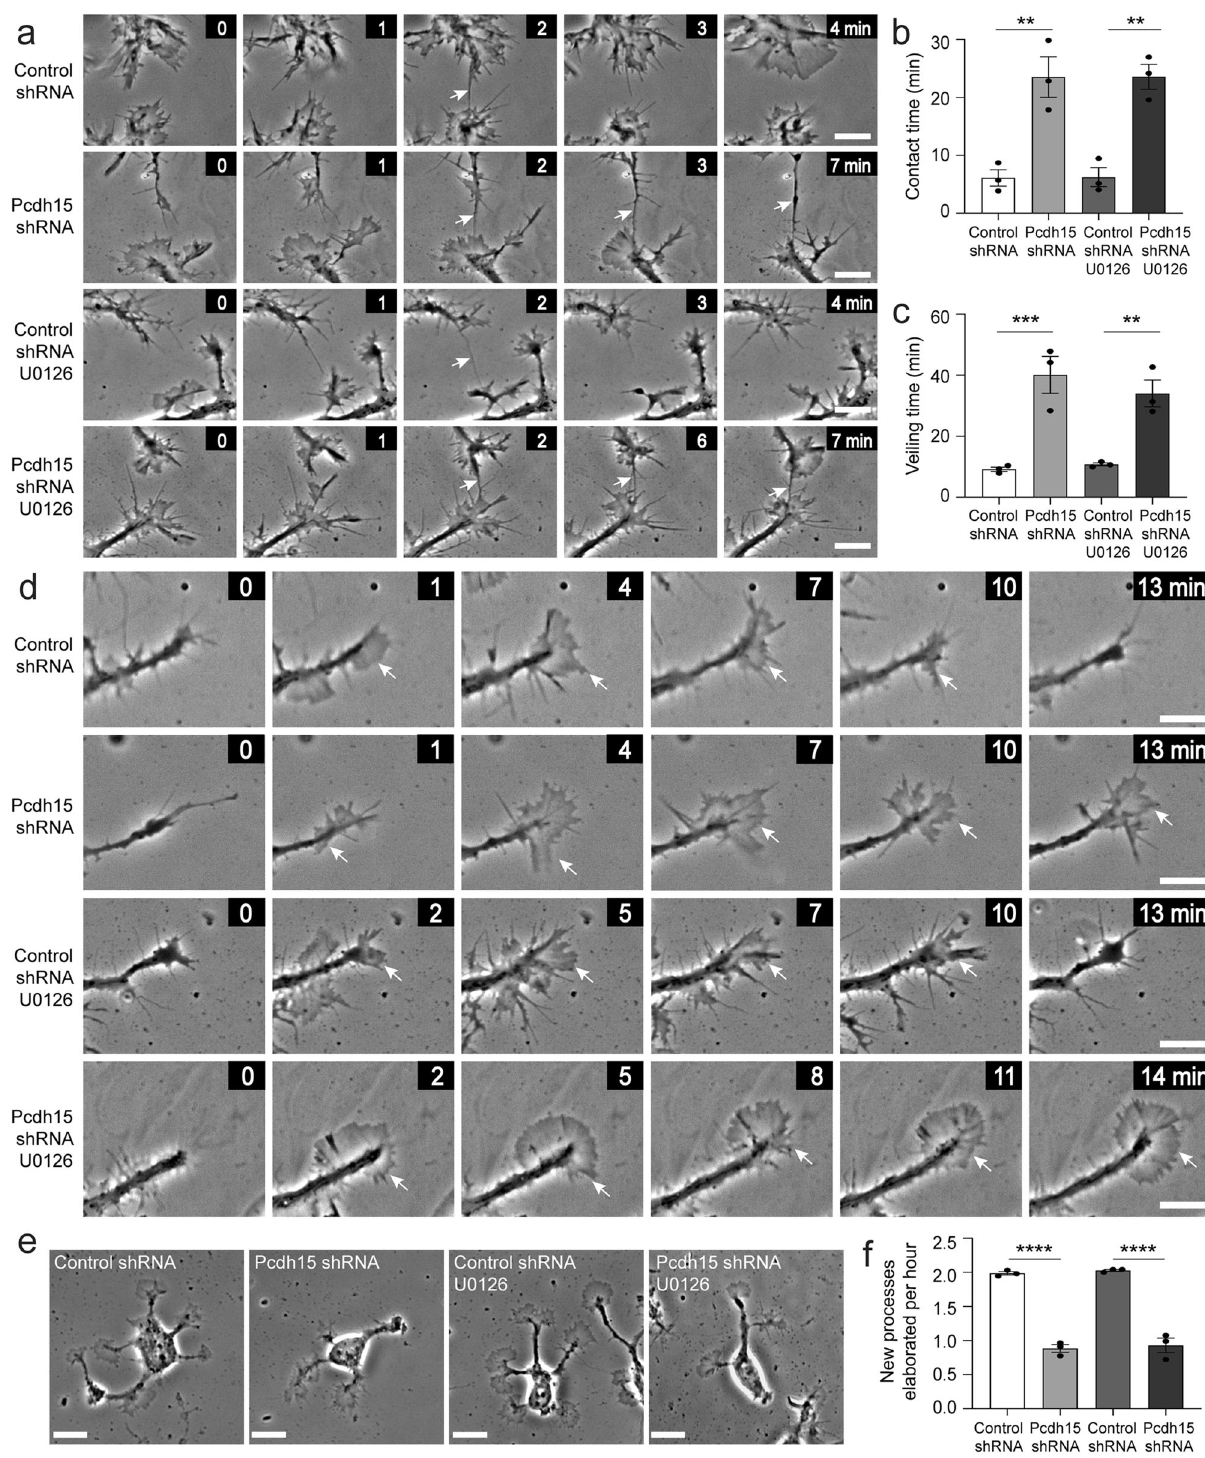
knockdown (Figs. 6 and 7). Instead, our qPCR and protein expression data indicated that Pcdh15 knockdown dysregulated ADF/Co fi lin and Arp2/3 activity in OPCs (Fig. 7). Inhibiting Cdc42 GTPase activity upstream of Arp2/3 activity, or Arp2/3 activity directly, rescued actin accumulation in the lamellipodia to the same extent, and inhibiting Cdc42 rescued lamellipodial and fi lopodial dynamics in Pcdh15 knockdown cultures (Fig. 9). Of note, Cdc42 inhibition not only failed to return OPC process